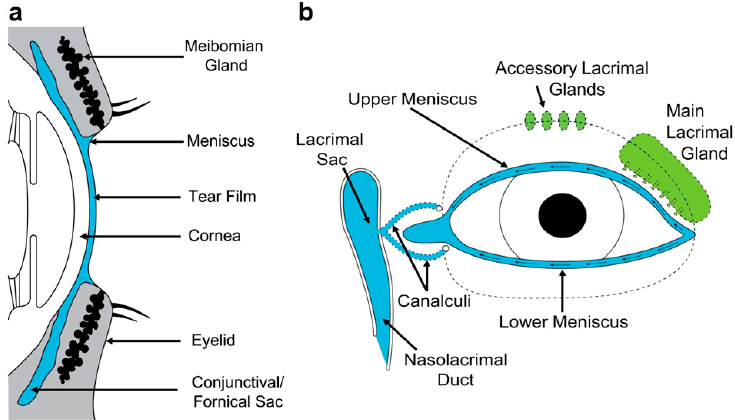
Figure 1. ( a ) Sagittal view of the eye to show tear distribution. ( b ) Schematic view of the lacrimal drainage system seen en face . (Reprinted with permission from ref. [18]. Copyright 2009 Elsevier Ltd.)